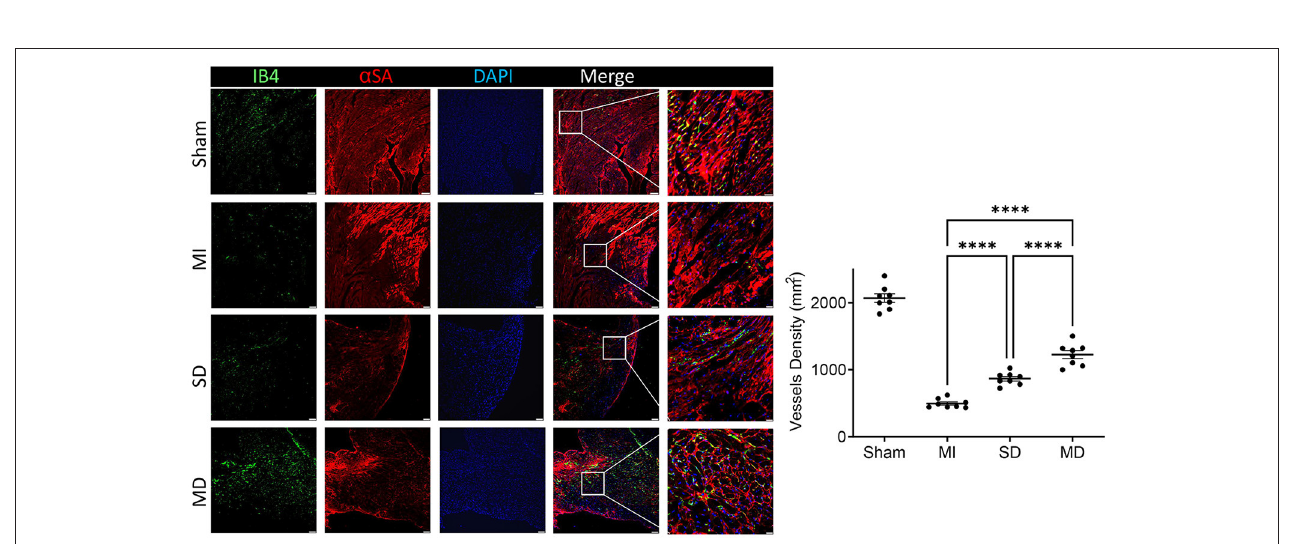
FIGURE 5 | Assessment of angiogenesis. Histochemical staining was performed on serial frozen sections of sham-operated, MI, SD, and MD-treated mouse hearts that were sacrificed 4 weeks after MI induction to confirm the presence of IB4. The number of capillaries is quantified as the number of IB4-positive vascular structures in the area around the infarct per square millimeter. Data are means ± SE. Eight animals per group. Scale bar = 20 and 10 µ m for the unenlarged and enlarged panels, respectively. One-way ANOVA with Dunn’s multiple comparisons test. **** p < 0.0001.